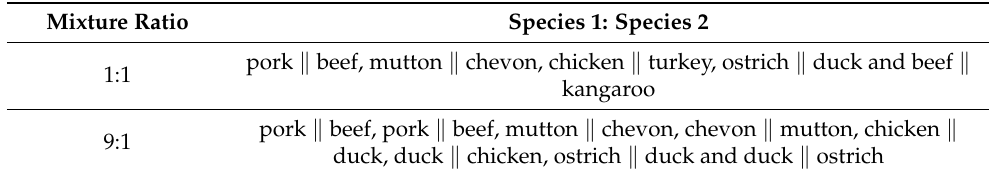
Table 1. Ratios and species of artificial DNA mixtures.